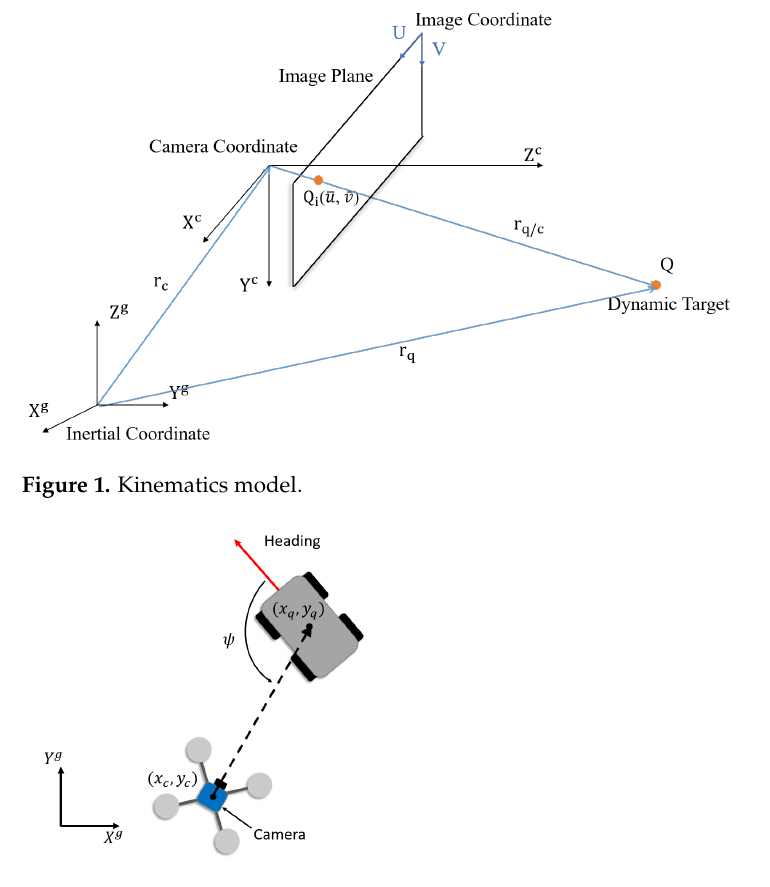
Figure 2. The definition of the orientation of target ψ observed by the